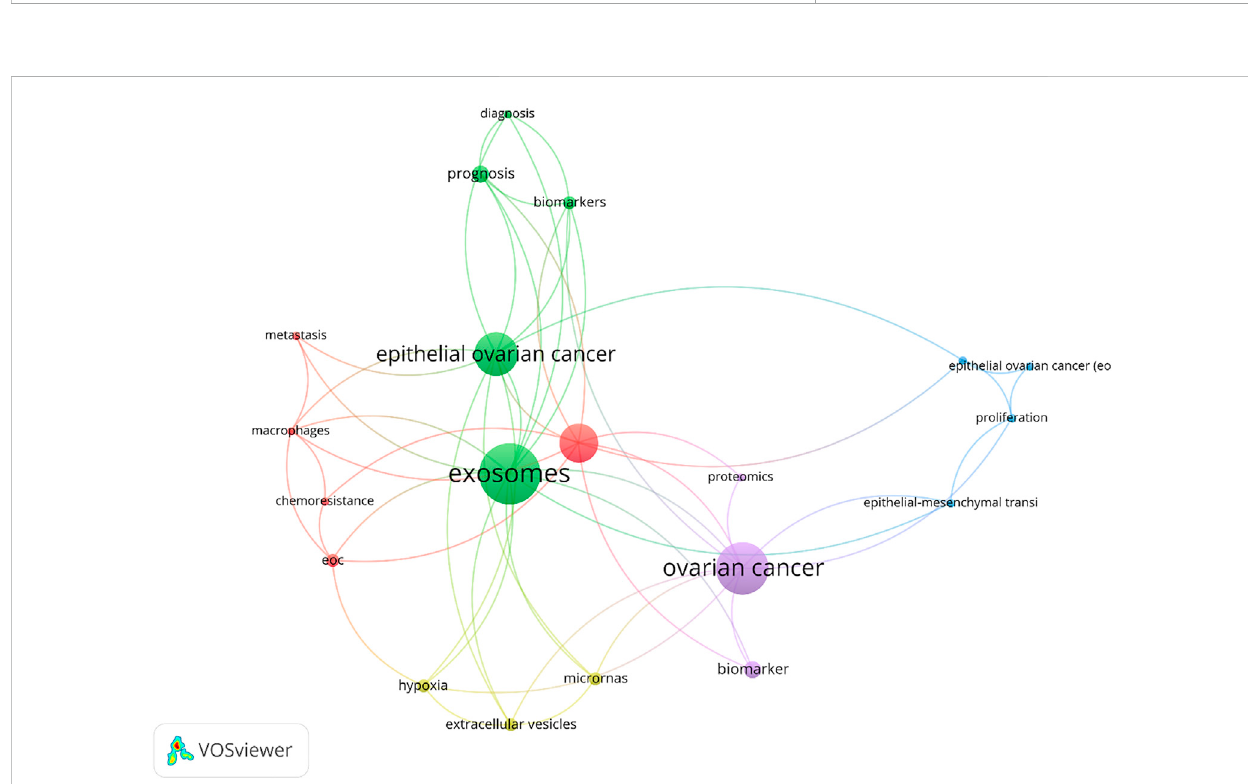
FIGURE 10 Co-occurrence author keyword (criteria: at least 2 author keyword